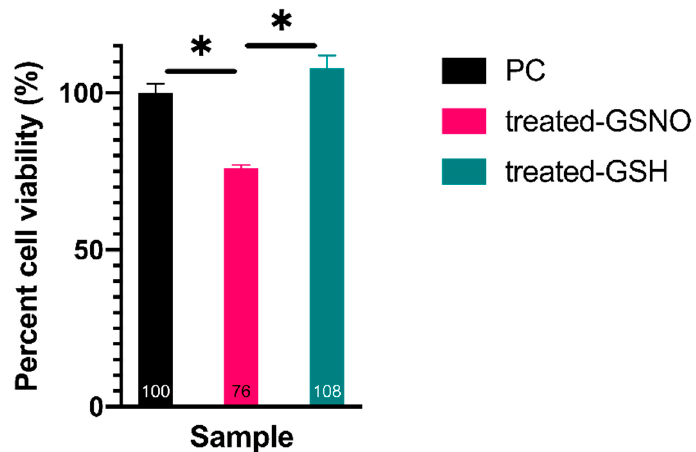
Figure 3. Percent cell viability of N2a neuroblastoma cells when exposed to 1 mM GSNO for 24 h at 37 ° C, 5% CO 2 assessed by the WST-8 assay. Data points represent the mean of n ≥ 9 data points ± standard deviation. One-way ANOVA results confirmed that treated-GSNO cells exhibited statistically different cellular viability than the PC and treated-GSH cells; the PC and treated-GSH samples were not statistically different at a 99% CI. Graphically, statistical significance at the 99% CI was illustrated using * (1 asterisk).